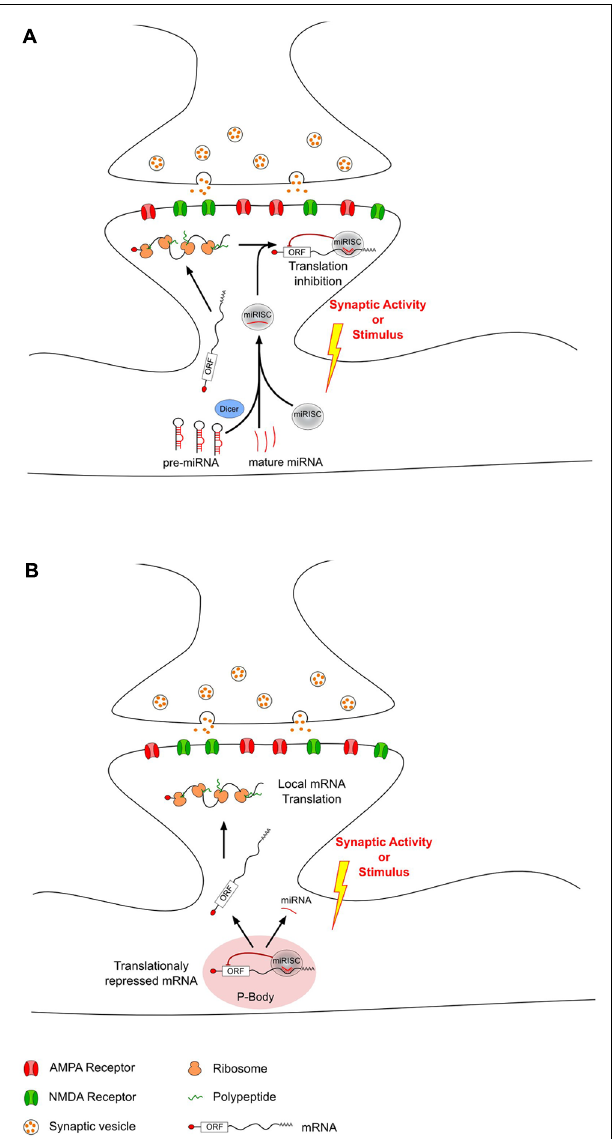
FIGURE 1 | MicroRNAs can modulate local translation in response to changes in synaptic activity. After transport from the soma to the dendrites, some mRNAs are locally translated into proteins.This local translation mechanism can be modulated in response to synaptic activity changes by dendritic miRNAs that have also been transported from the soma.This miRNA-driven mechanism can either decrease (A) or increase (B) local translation. (A) Decrease of local translation could be the result of an activity-related miRNA loading into miRISC and specific binding to target mRNAs. (B) Increase of translation may be the consequence of an unbinding of miRNA from target-mRNAs which could then escape P-body and undergo local